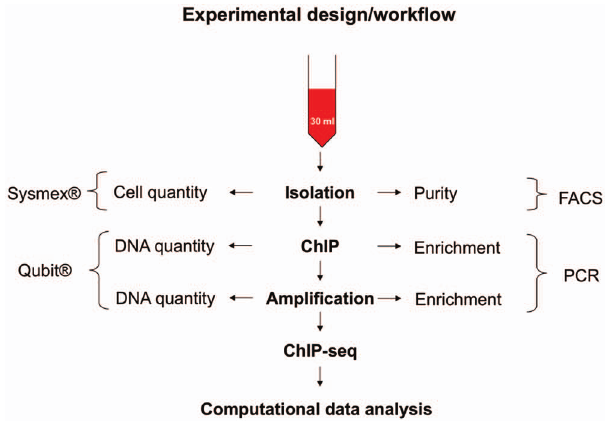
Figure 1. Experimental design/workflow. Diagram shows the experimental design for a complete workflow to analyse genome wide histone modifications of CD 14 ++ CD 16- monocytes using 30 ml of